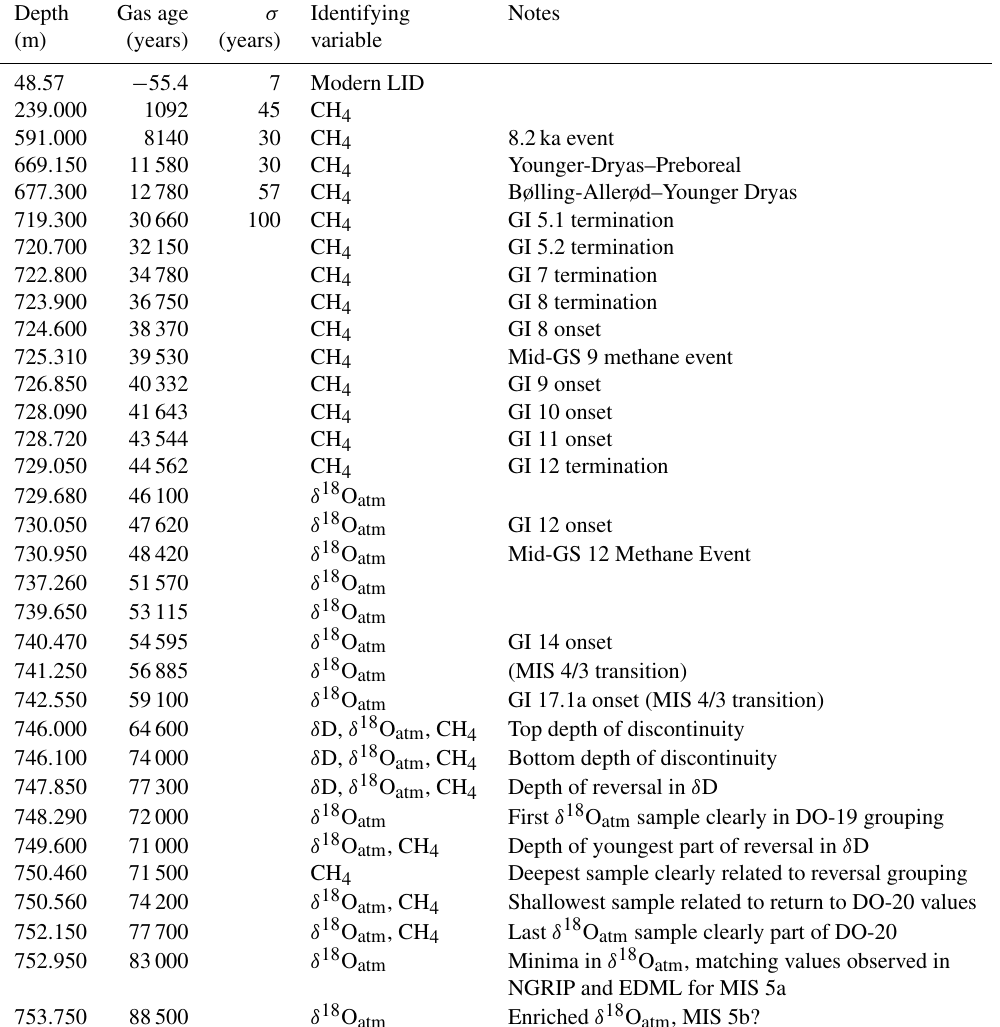
Table 1. Prior gas age constraints and uncertainty are based on matching of features in the atmospheric history of methane and δ 18 O atm . Name or description of feature are given in the notes and the primary parameter used to identify the feature is provided as the identifying variable. Age uncertainty is related to the duration of the feature; see